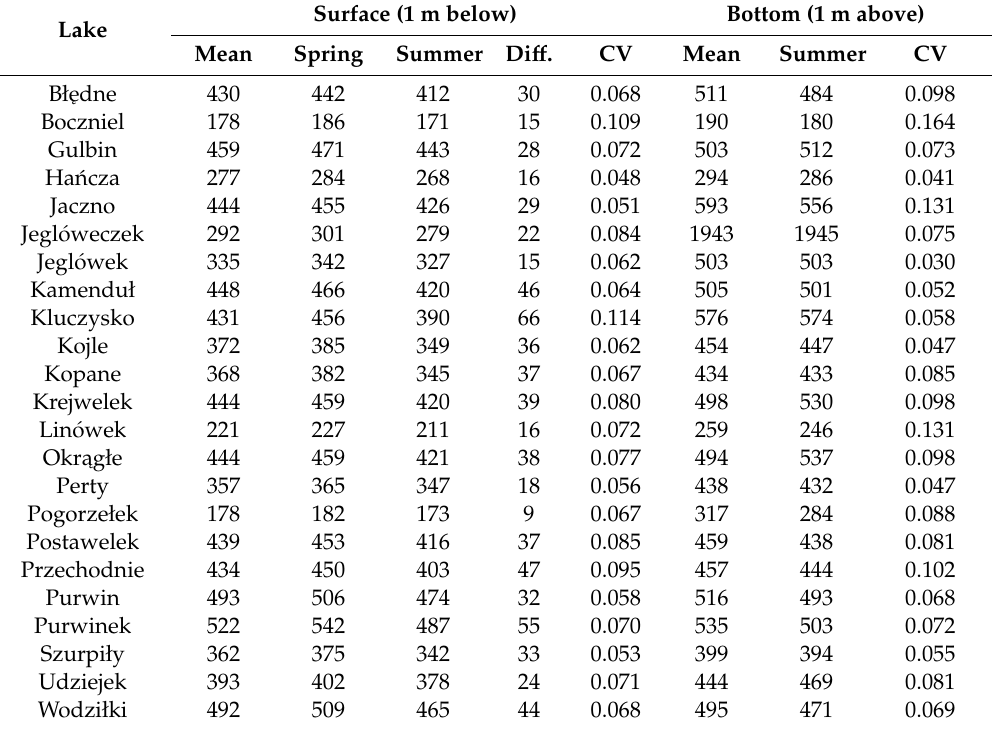
Table 2. Conductivity characteristics of surface and bottom waters of the studied lakes calculated for the period of 2012–2014. Di ff . is the di ff erence in conductivity during the spring homothermy and during summer stratification (spring − summer in table), CV = coe ffi cient of